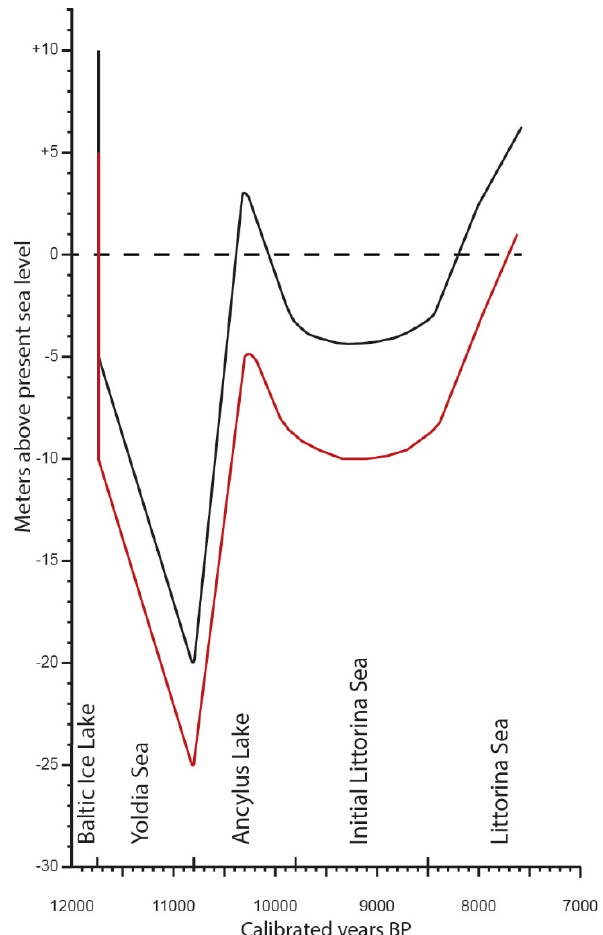
Figure 3. Shoreline displacement record from Haväng (red line) [6], and a corresponding, interpolated record for western Blekinge (black line) [87] spanning the early and mid-Holocene. Shoreline reconstructions were made using the ArcGIS 10.3 software based on the shoreline displacement records from Haväng [6] and Blekinge [93]. Five palaeo-shoreline maps, showing the